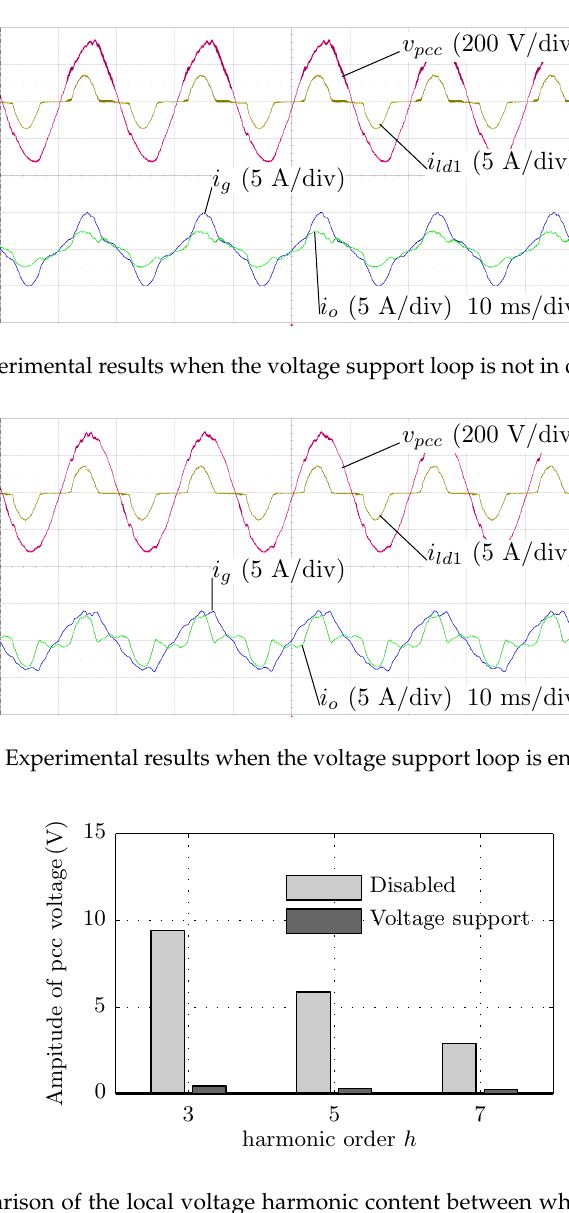
Figure 11. Comparison of the local voltage harmonic content between when the proposed voltage support is disabled and when it is in